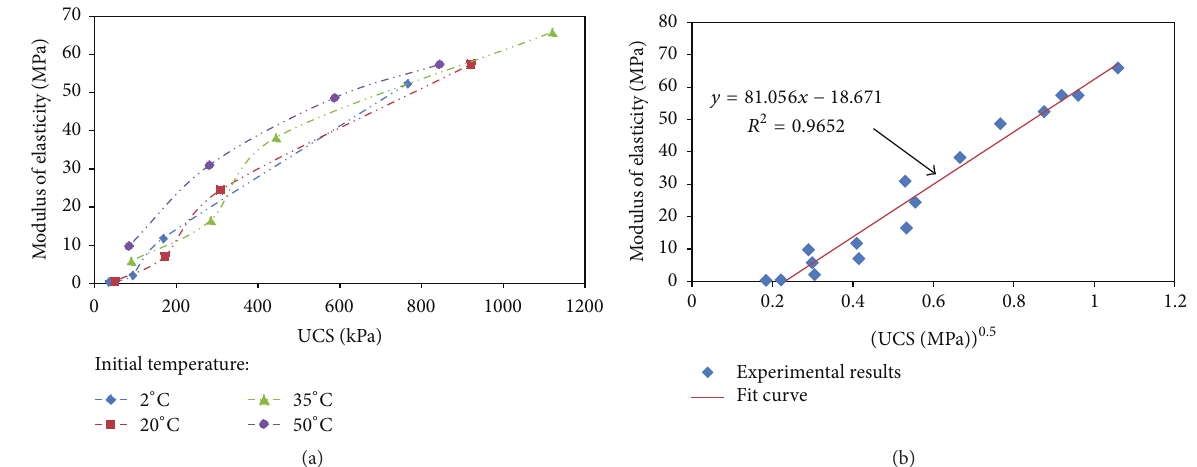
Figure 7: Relationship between 𝐸 and UCS: (a) evolution of 𝐸 with the various UCS at different initial temperature and (b) fit curve for 𝐸 and square root of the UCS.